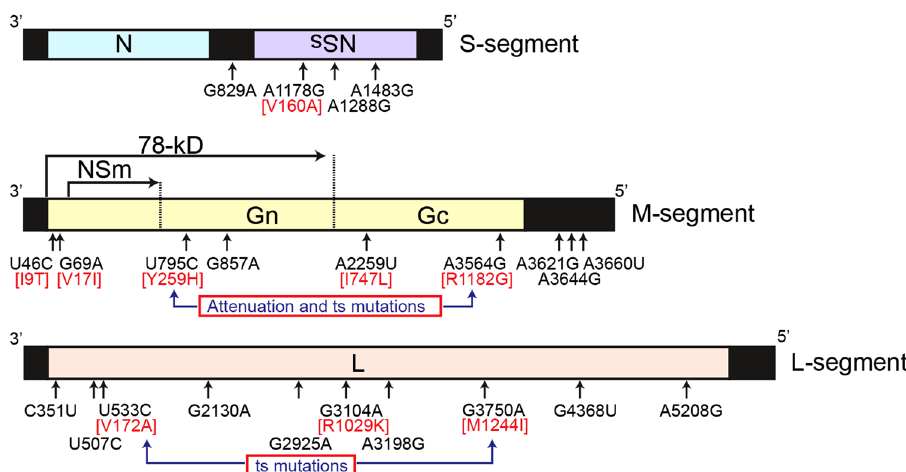
Fig. 1 Schematics of MP-12 vaccine mutations. The genomic RNA of Small (S)-segment, Medium (M)-segment, and Large (L)-segment are shown. Mutations of the MP-12 vaccine compared to the parental ZH548 strain are indicated by arrows , and amino acid substitutions are shown in red . Reported attenuation mutations in the M-segment and temperature-sensitive (ts) mutations in the M-segments and L-segments are also